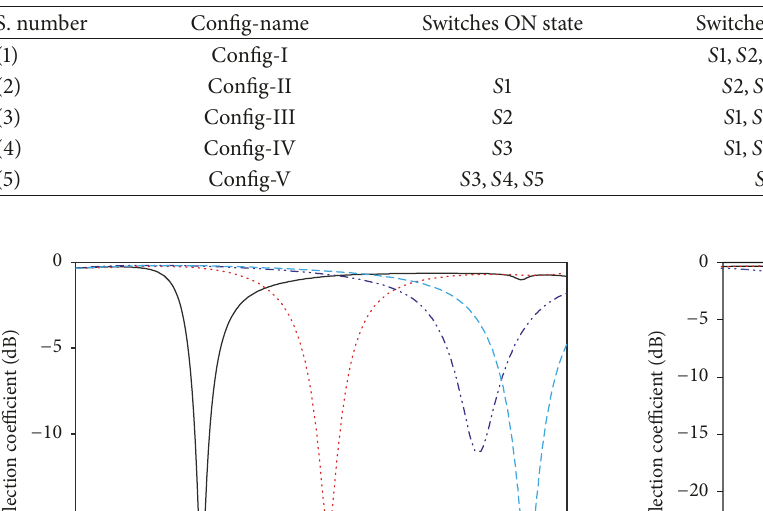
Table 3: Various configurations of the proposed FR antenna.